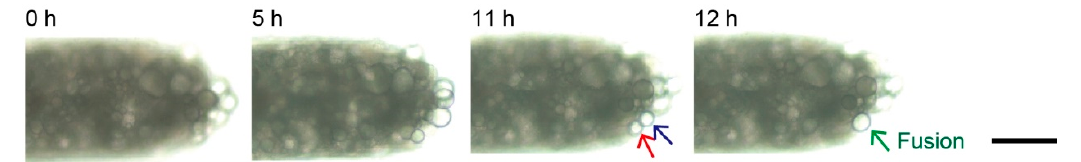
Figure 9. Time-lapse images of an adipocyte microfiber on the anchoring device. A fusion (green arrow) of lipid droplets (red and blue arrows) was observed. Scale bar is 100 µm.